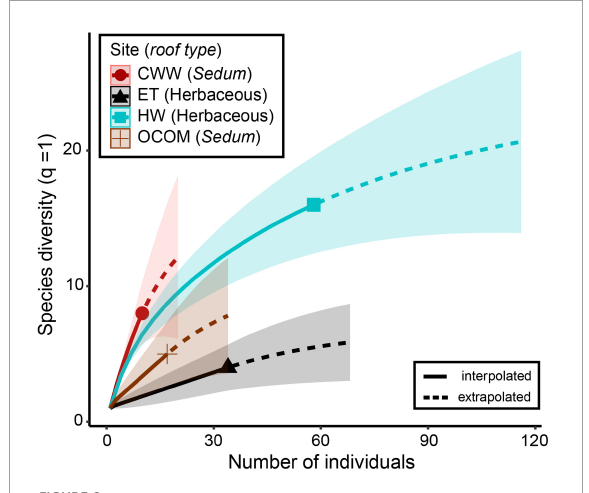
FIGURE6 Sample-based species accumulation curves for Shannon diversity ( q = 1) based on rarefaction (solid line segment) and extrapolation (dotted line segments) with bootstrapped 95% confidence intervals (shaded areas) for Hymenoptera specimens ( N = 119) collected from April to June of 2015 for each green roof locations: Central Wine Warehouse (CWW), Hamilton West (HW), EcoTrust (ET), and Oregon College of Oriental Medicine